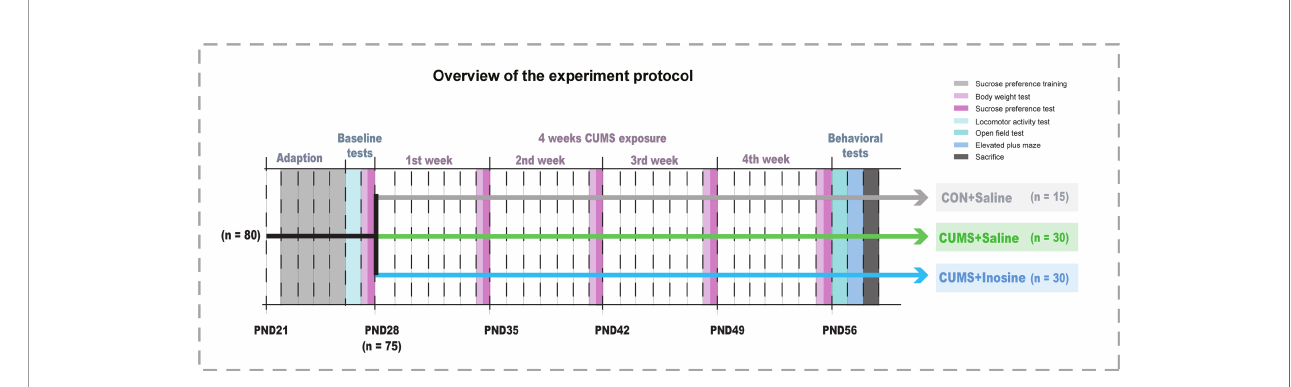
FIGURE 1 | Experimental design of